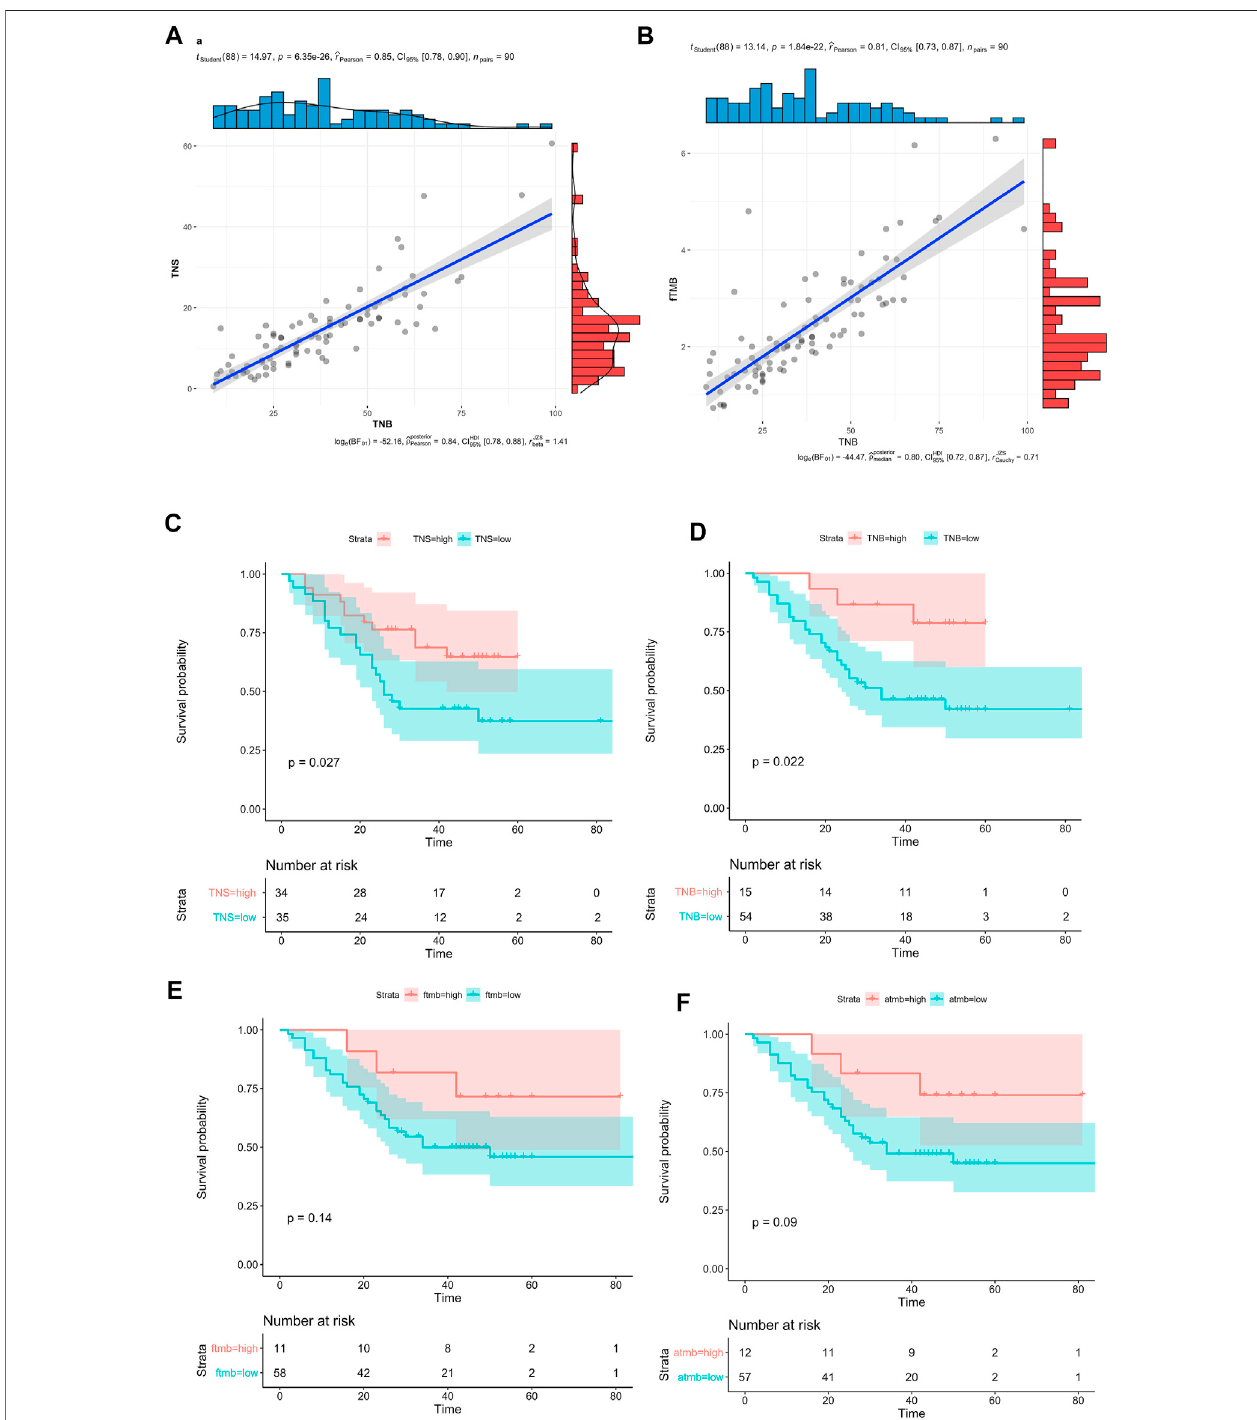
FIGURE 4 | Neoantigen in ESCC. (A) The correlation bewtten TNB and TNS, (B) Compared the mean value between TNB and fTMB, (C) Survival analysis of TNS (high TNS > 2.2), (D) Survival analysis of TNB (high TNB > 2.5), (E) Survival analysis of fTMB (high fTMB > 1.6), (F) Survival analysis aTMB (high aTMB > 1.8).